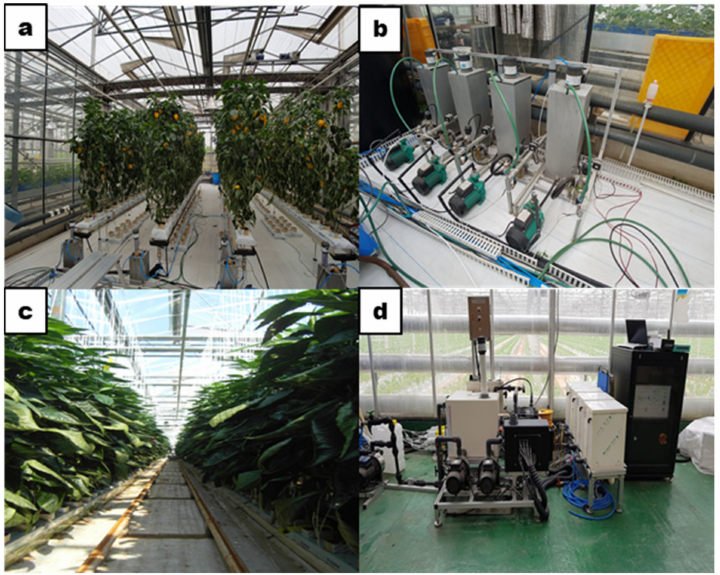
Figure 1. Experimental views of sweet pepper cultivation in greenhouses: an experimental green- house at Seoul National University Farm, Suwon, Korea ( a ) with irrigation systems ( b ), and a commercial greenhouse at Hwasung 21, Hwasung, Korea ( c ) with irrigation systems ( d